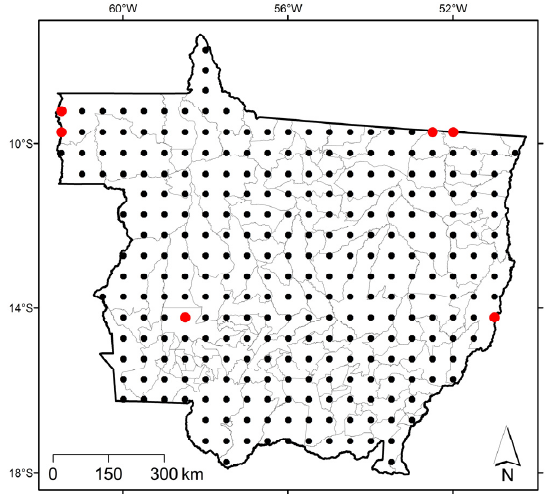
Figure 8. Sampling design (5 km bu ff er zone in the confluence of regular 0.5 × 0.5 degree, full latitude and longitude grid) for validation of PROBA-V´s estimates of croplands in the Mato Grosso State. Total number of samples = 292. Polygons inside the map correspond to the municipality boundaries. Red-colored samples were excluded from the analysis because of the unavailability of cloud-free Landsat scenes.